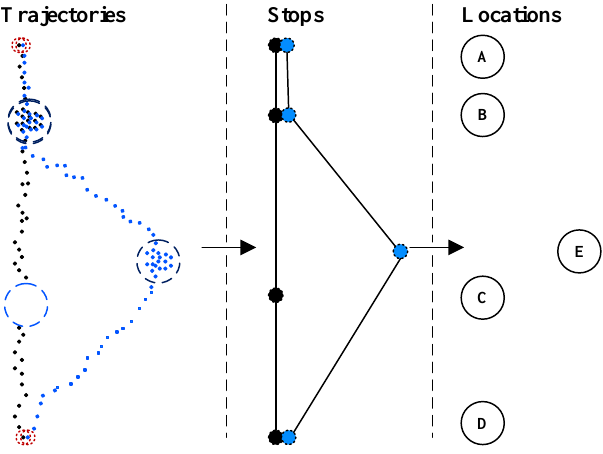
Figure 1. The flow chart of location extraction.